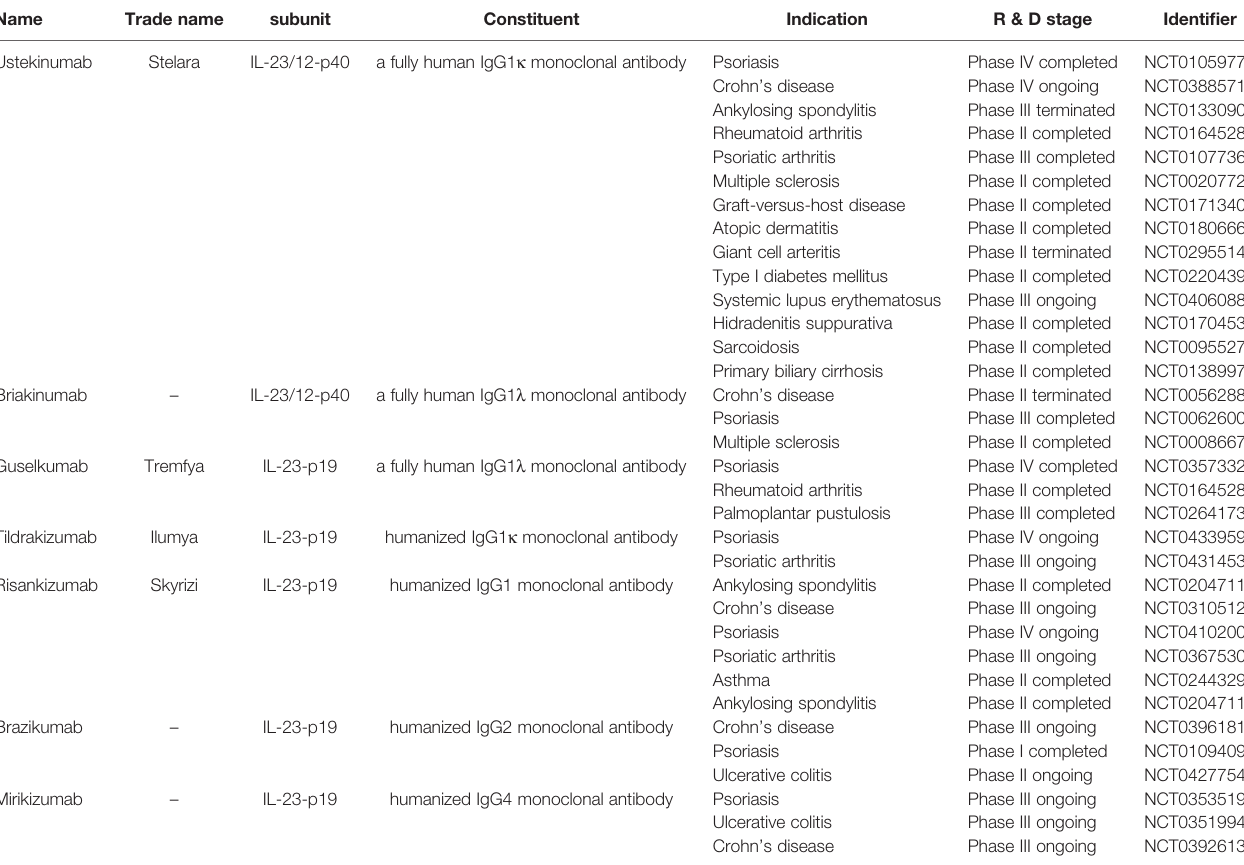
TABLE 1 | Summary of Biological Agents Targeting